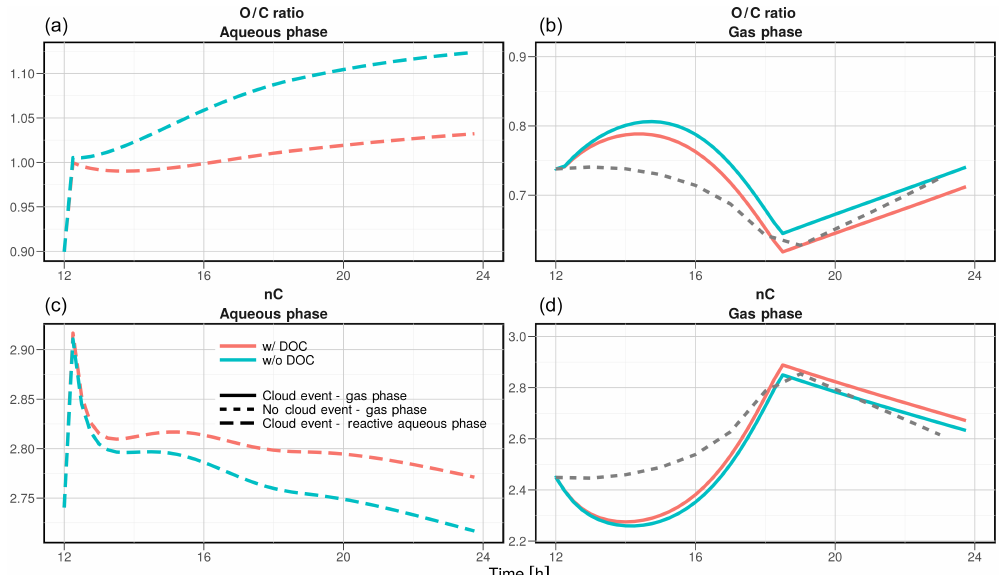
Figure 6. Time evolution of the mean O / C ratio for the reactive species (top; ratios are calculated on a number of atoms basis; CO, CO 2 , CH 4 , and iron-organic complexes are excluded from the calculation) and the mean number of carbon atoms n C (bottom) in the aqueous phase (left) and in the gas phase (right) for the gas phase simulation (short dashed lines) and the cloud simulation (continuous lines). Cloud simulations are depicted with (red lines) and without (blue lines)